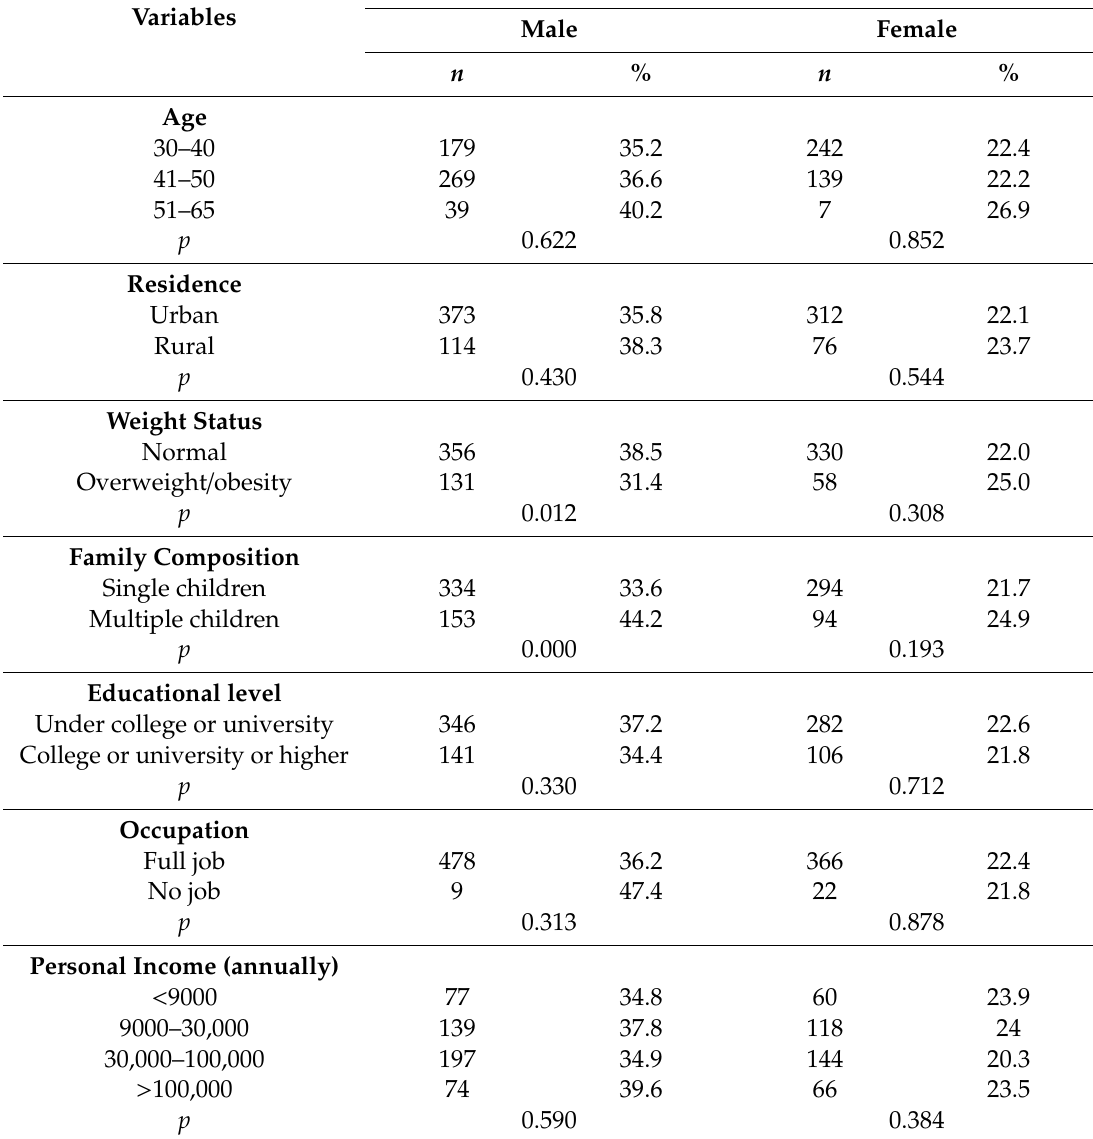
Table2. Prevalenceofmeetingthemuscle-strengthening(MS)activitiesguidelinesbysociodemographic factors and